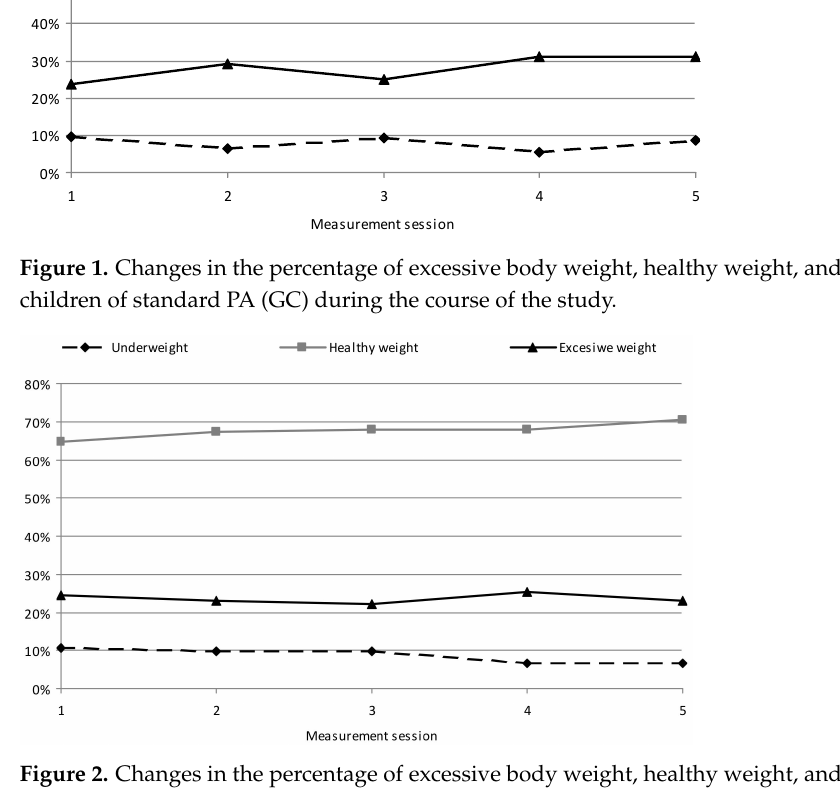
Figure 2. Changes in the percentage of excessive body weight, healthy weight, and underweight in children of elevated PA (SC) during the course of the